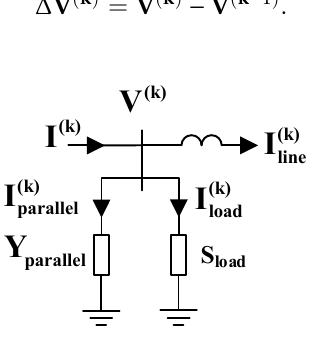
Figure 2. Currents that flow in a bus.